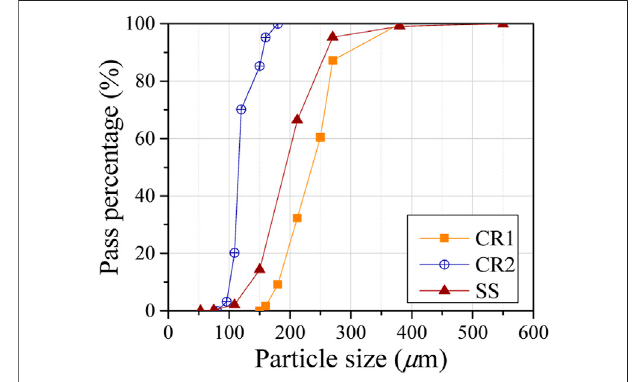
FIGURE 1 | Particle size